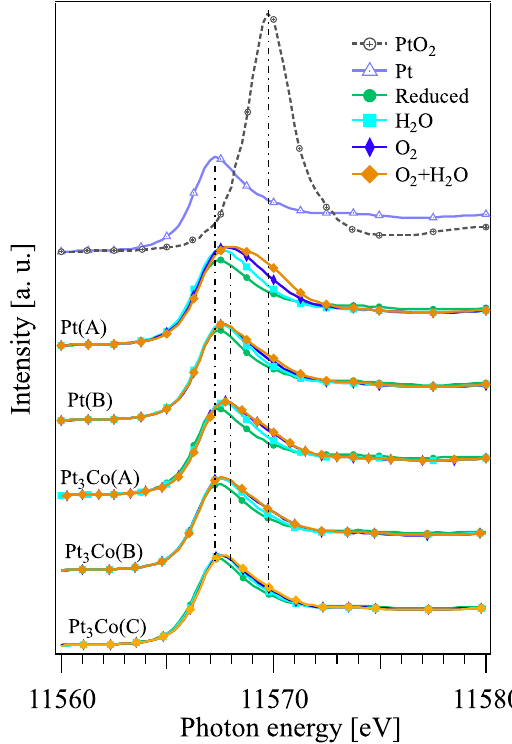
Figure 4. In situ HERFD-XAS spectra of Pt and Pt 3 Co nanoparticles under reduced condition, O 2 , H 2 O, as well as O conditions. The vertical dotted-broken lines are drawn to the peak positions of Pt foil, PtO 2 , and Pt(A) under O 2 + H 2 O